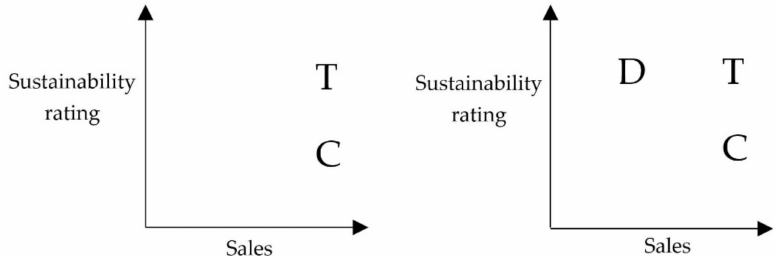
Figure 1. Exemplary illustration of the implementation of the decoy dishes. Note: Left: Without decoy dish / attraction e ff ect, Right: With decoy dish / attraction e ff ect. T = target dish, C = competitor dish, D = decoy dish. The figure based on [50].